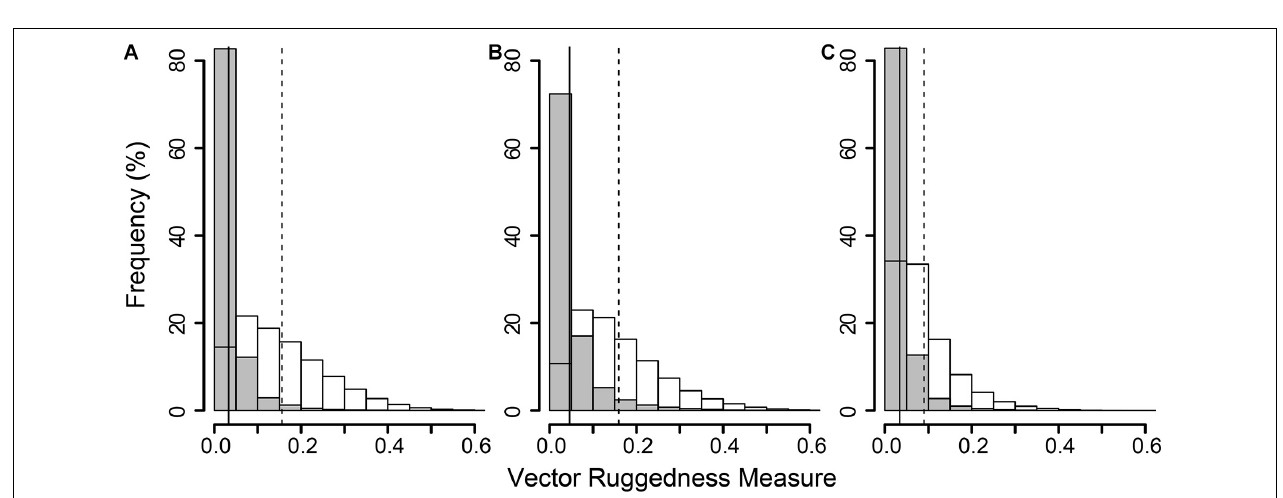
FIGURE 5 | Histogram of all Vector Ruggedness Measure (VRM) values of all pixels in the non-reef class (grey) and coral reef class (clear) at sites A (A) , B (B) , and C (C) . Vertical lines indicate mean VRM values for non-reef (solid) and reef substrate (dashed).